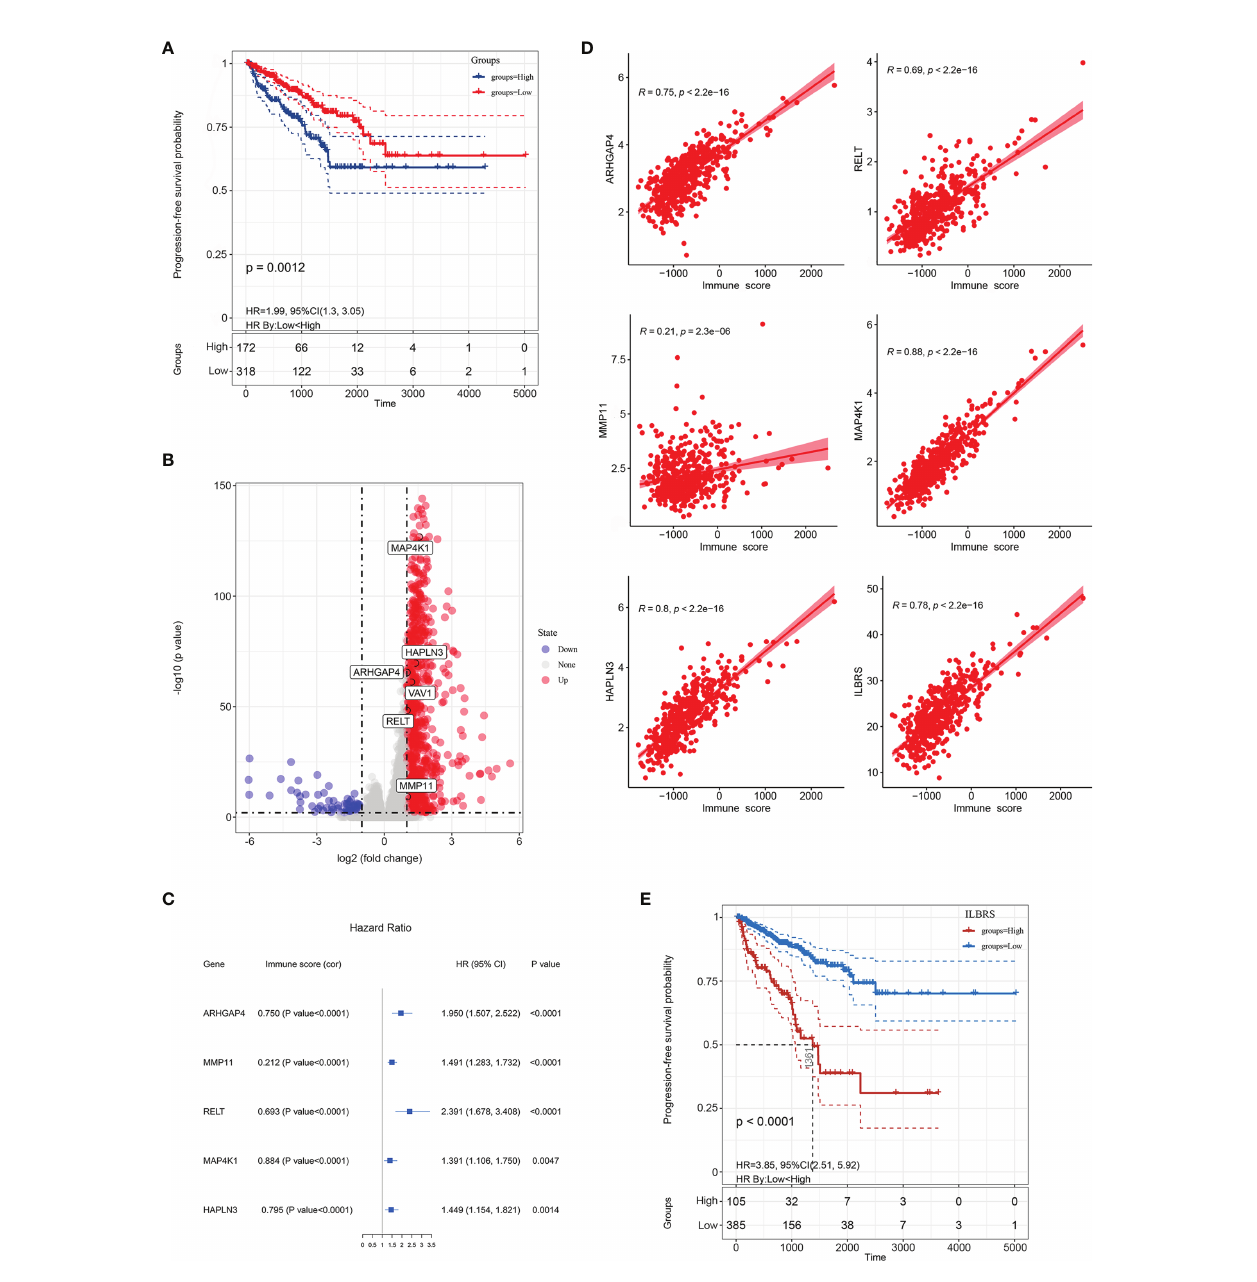
FIGURE 2 | Establishment of immune landscape-based risk score (ILBRS). (A) Kaplan – Meier curves for high and low immune score patient groups in TCGA-PRAD data. (B) Volcano plot of immune landscape-based DEGs (IL-DEGs). (C) Forest plot of the results of univariate Cox regression analyses of IL-DEGs included in the ILBRS formula. The square data markers indicate the estimated hazard ratios (HRs). Error bars represent 95% con fi dence intervals (CIs). “ cor ” indicates the coef fi cient gained through Pearson correlation analysis. (D) Pearson correlation analysis of ILBRS and its variables with immune scores. (E) Kaplan – Meier curves for high and low ILBRS patient groups in TCGA-PRAD